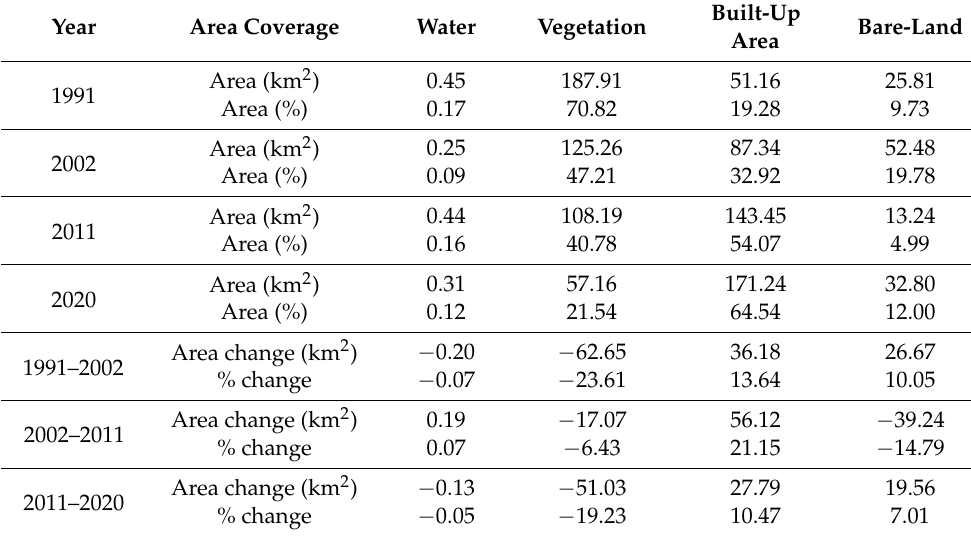
Table 3. Area and percentage changes in LULC classification types between 1991 and 2020. Year Area Coverage Water Vegetation